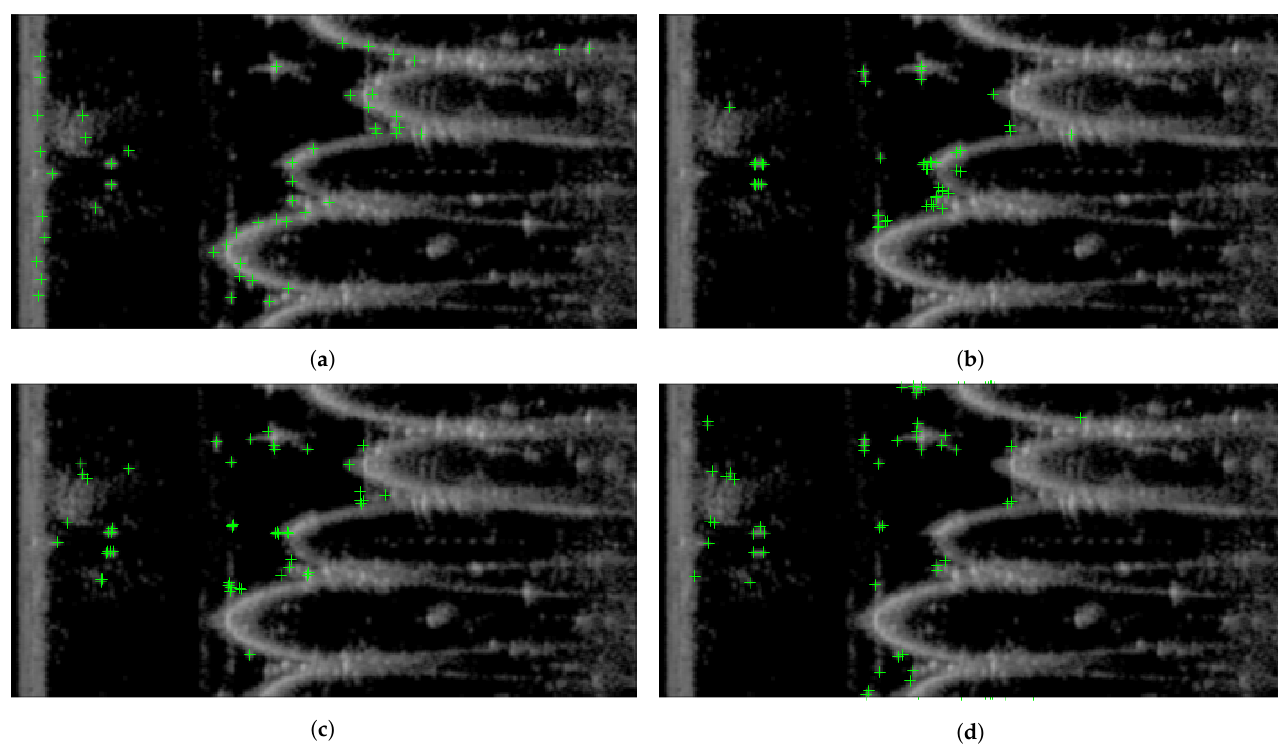
Figure 21. Illustration of the 50 best interest point detected in image 6 of dataset 2 with each algorithm under analysis employing the selection module. ( a ) Interest point detection with SURF algorithm, ( b ) interest point detection with ORB